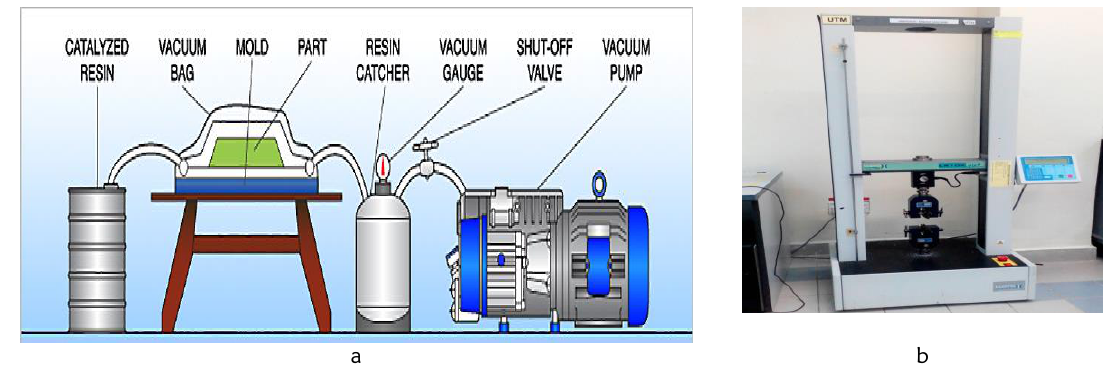
Figure 1: Experimental setup; (a) vacuum infusion process, and (b) universal testing